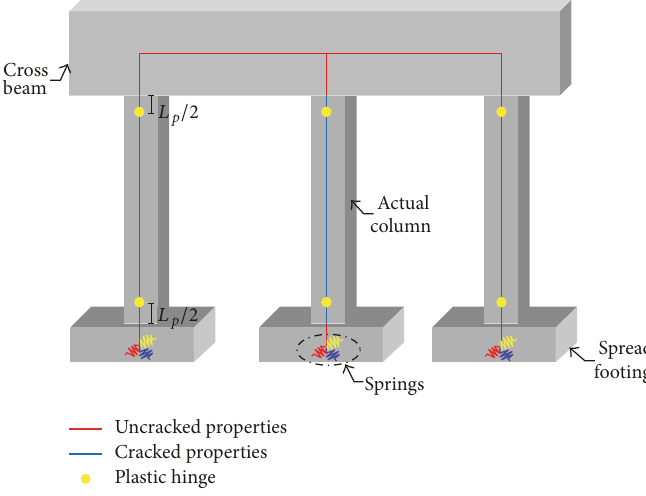
Figure 2: Bridge pier elements and associated